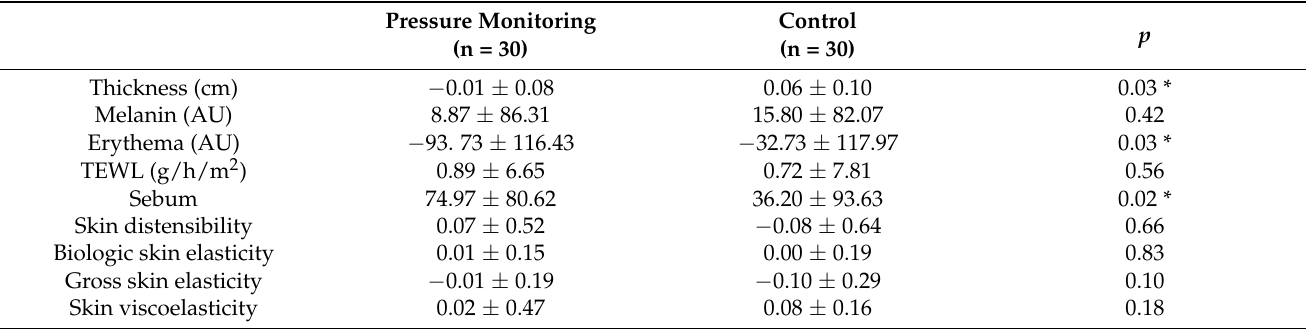
Table 3. Change score (pre- to posttreatment) on measured